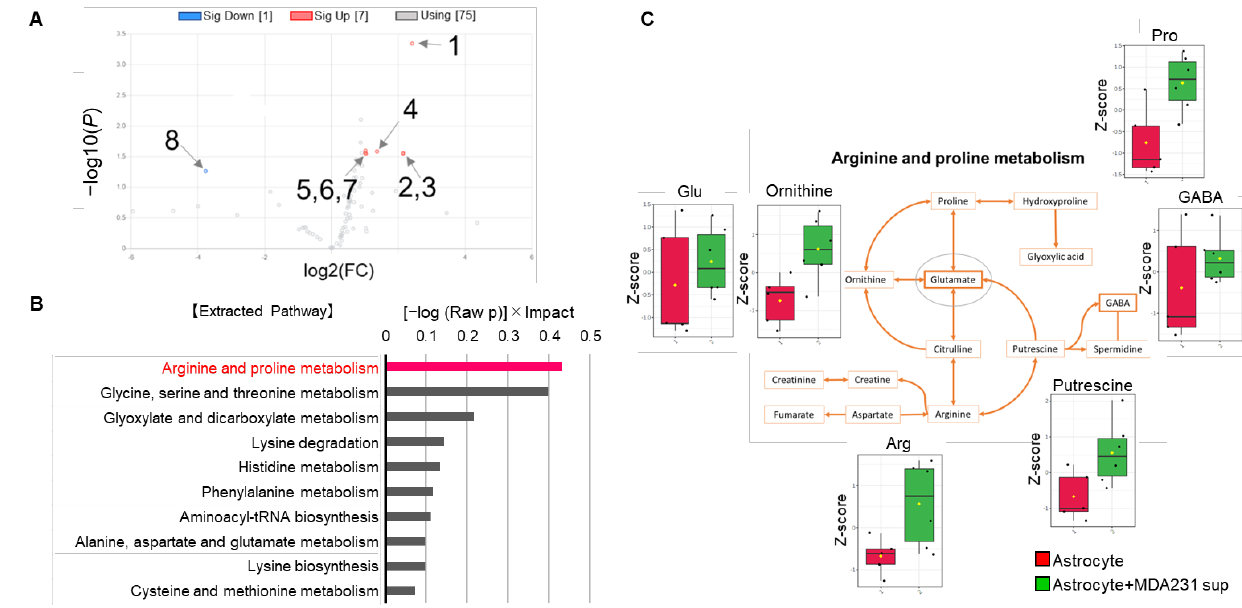
Figure 2. Metabolome changes in astrocytes by indirect coculture with MDA231. ( A ) Volcano plot of altered metabolites after indirect coculture (n = 6) for a single cultured astrocyte (n = 4). 1—Spermidine; 2—Adenosine; 3—Guanosine; 4—Glycine; 5—Ornithine; 6—Homoserine; 7—Lysine; 8—Glyoxylic acid. See the supplementary Table S2. ( B ) Pathways extracted by metabolome enrichment analysis from metabolites selected by volcano plots. The bar length indicates the value of “( − log (Raw p )) × Impact” in descending order. ( C ) Arginine and proline metabolic pathways with the detected metabolites (n = 3) as a Z-score. Data scaling (Z-scoring) was performed by MetaboAnalyst 4.0 as mean-centered and divided by standard deviation of each